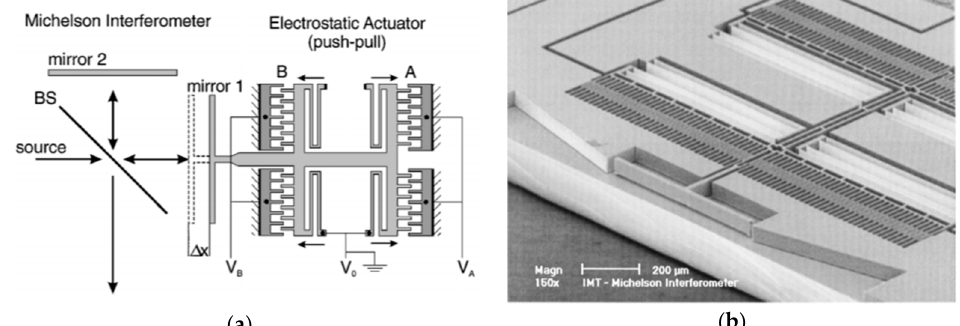
Figure 4. An in-plane electrostatic comb micro-electromechanical system (MEMS) based Fourier transform spectrometers (FTS): ( a ) Schematic of FTS; ( b ) scanning electron microscope (SEM) of the MEMS mirror. (Reprinted with permission from Reference [7] The Optical Society).